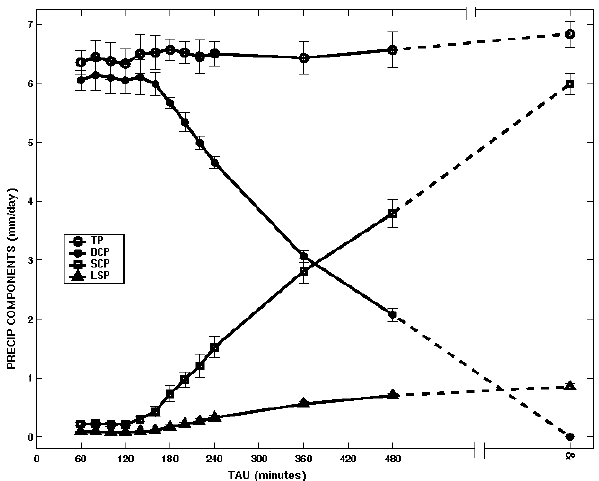
Fig. 2. Area averaged, time mean total precipitation (TP) and its various components (DCP, SCP and, LSP) versus TAU for the re- gion (0 ◦ E to 360 ◦ E and 12.5 ◦ S to 12.5 ◦ N). Points showed adja- cent to the right margin represent TAU= ∞ . The error bars show the respective standard deviation in time about the time mean val- ues. Notations: TP for total precipitation, DCP for deep convective precipitation, SCP for shallow convective precipitation, and LSP for large-scale precipitation (also called as stratiform